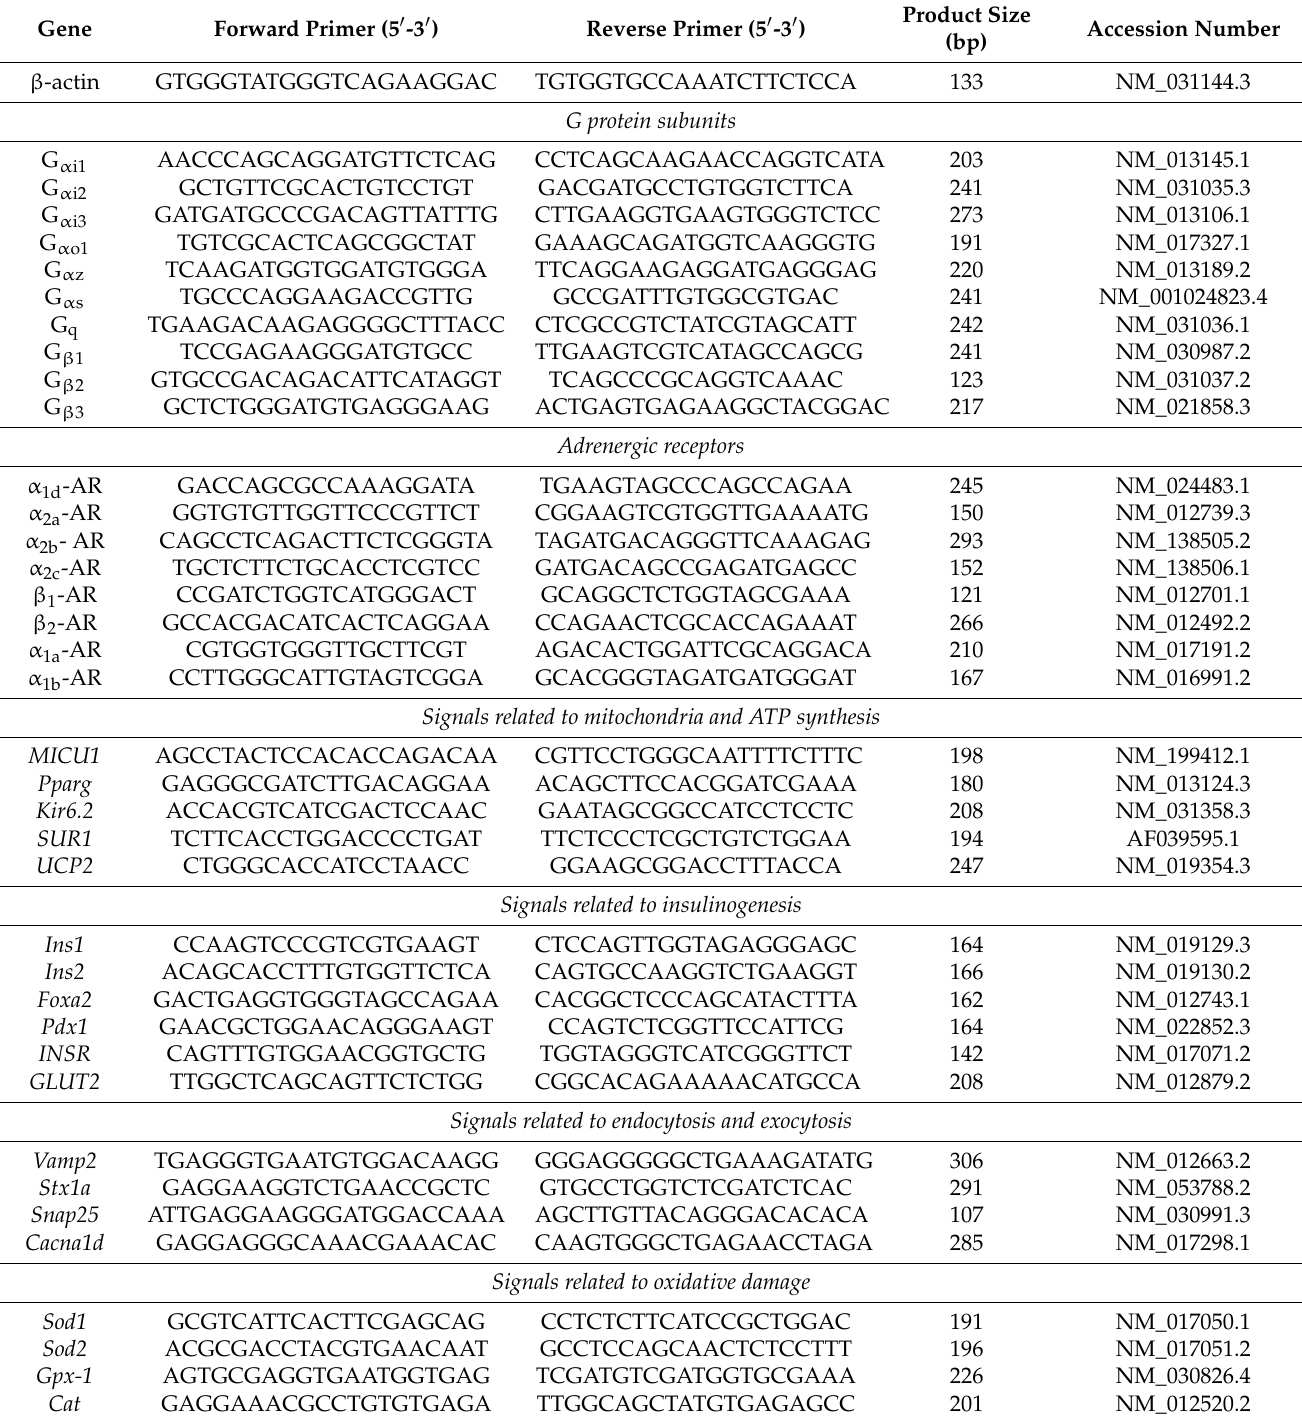
Table 1. Primer sequences of target genes analyzed in islets by quantitative real time